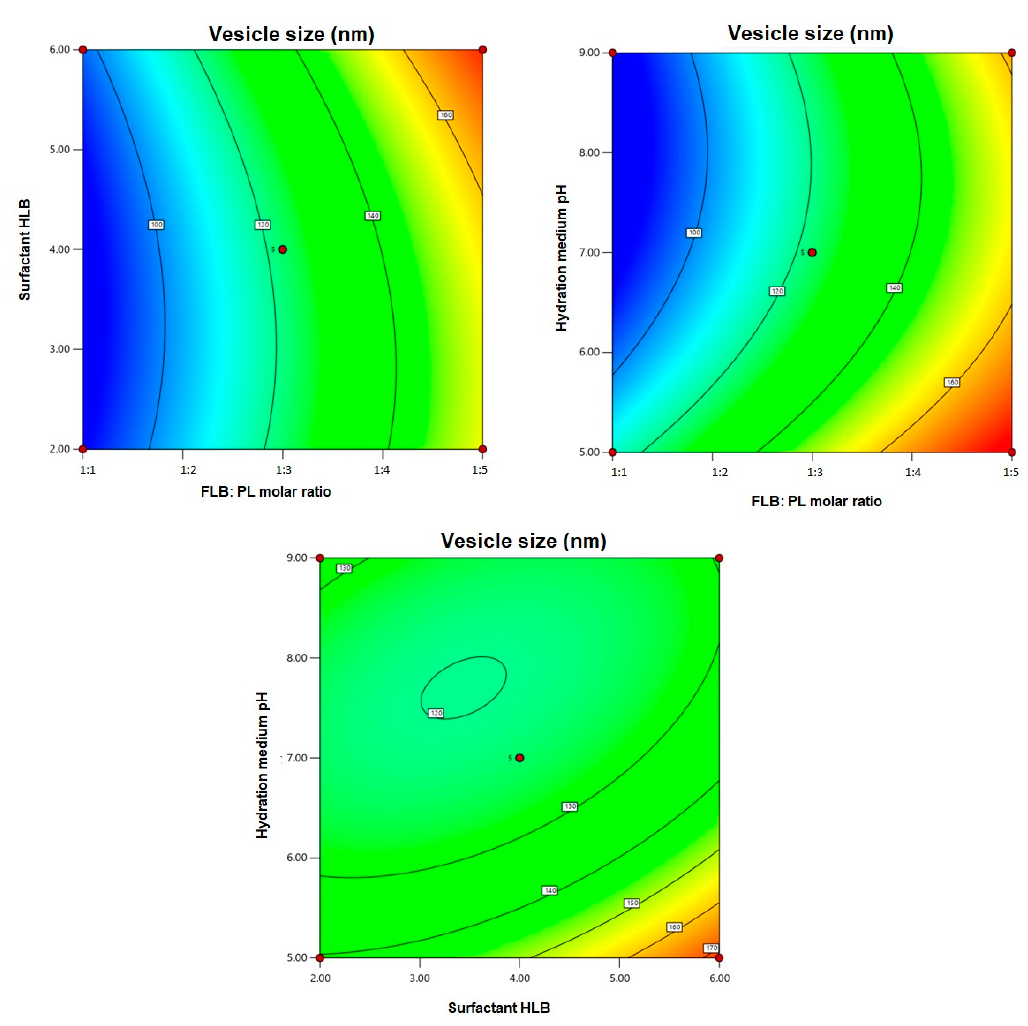
Figure 2. Contour plot for the effects of FLB-to-phospholipid (PL) molar ratio ( X 1 ), surfactant hydrophilic lipophilic balance (HLB) ( X 2 ), and hydration medium pH ( X 3 ) on the vesicle size of FLB TRF.